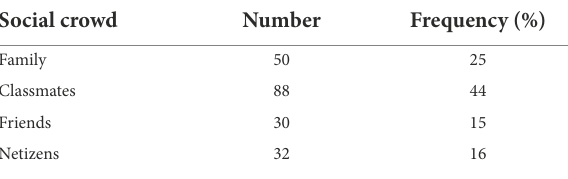
TABLE 3 The most common social circles of college students in the online education